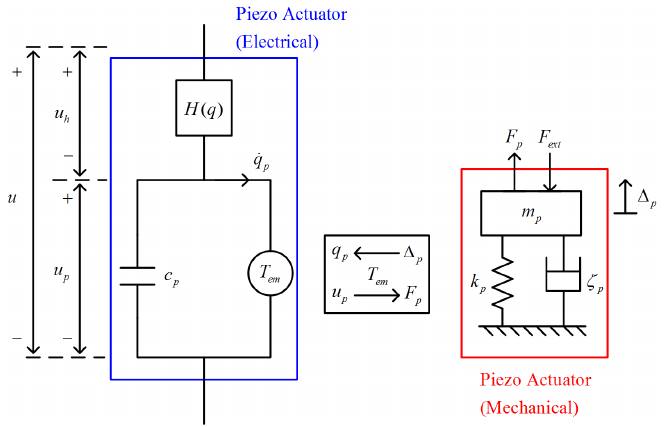
Figure 2. Model of a piezoelectric transducer.